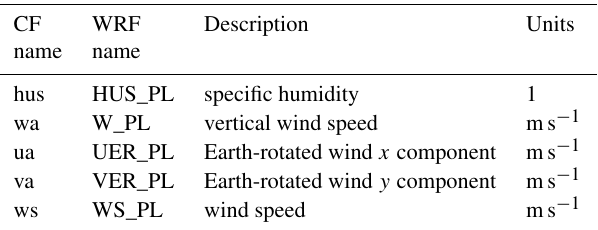
Figure 1. Calculation of diagnostics according to the time step for each kind of variable (see tables in Appendix B). Table 2. Description of CORDEX additional pressure-interpolated variables provided with the